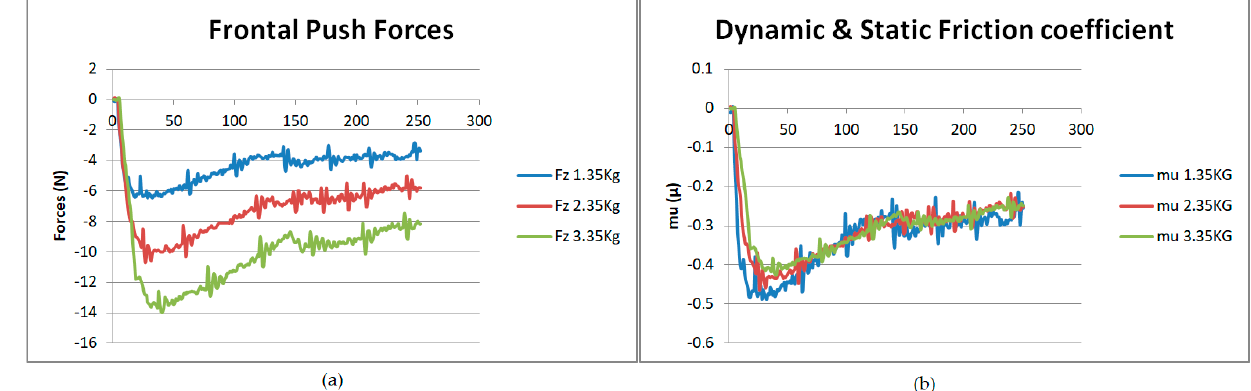
Figure 16. ( a ) Frontal force needed to move the box over the surface, depending on its weight. ( b ) Calculus of the friction coefficient of the box, depending on the weight.